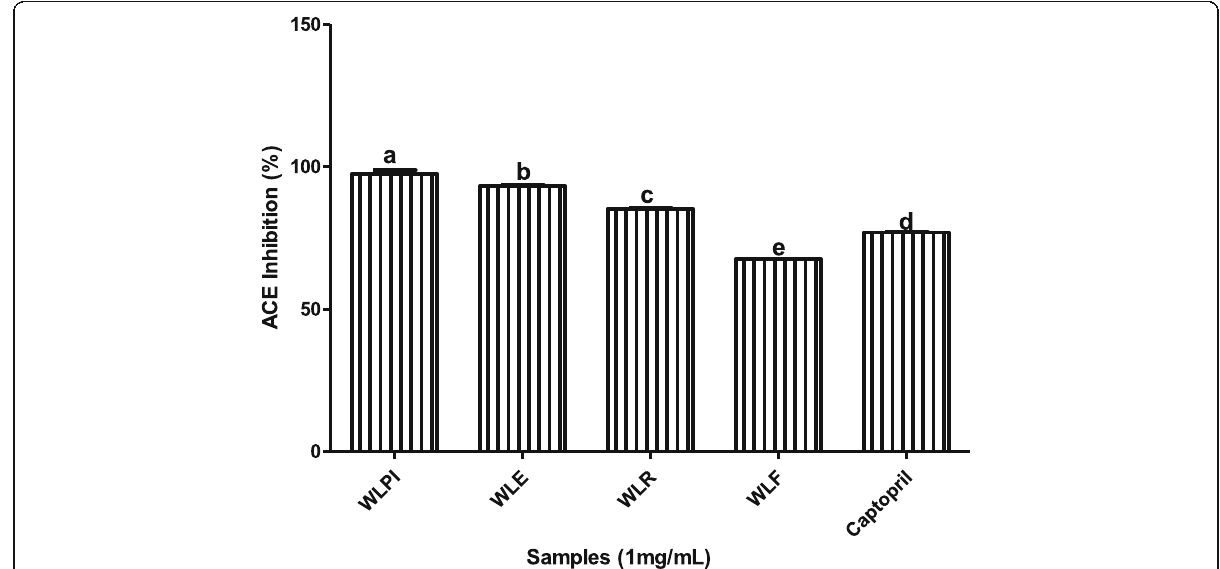
Fig. 2 Angiotensin converting enzyme inhibitory activities of wild lettuce powder. Key: WLF; Whole wild lettuce powder, WLE; Wild lettuce extracts, WLR; Wild lettuce Residue, WPI; Wild lettuce protein isolate, Captopril (Antihypertensive synthetic